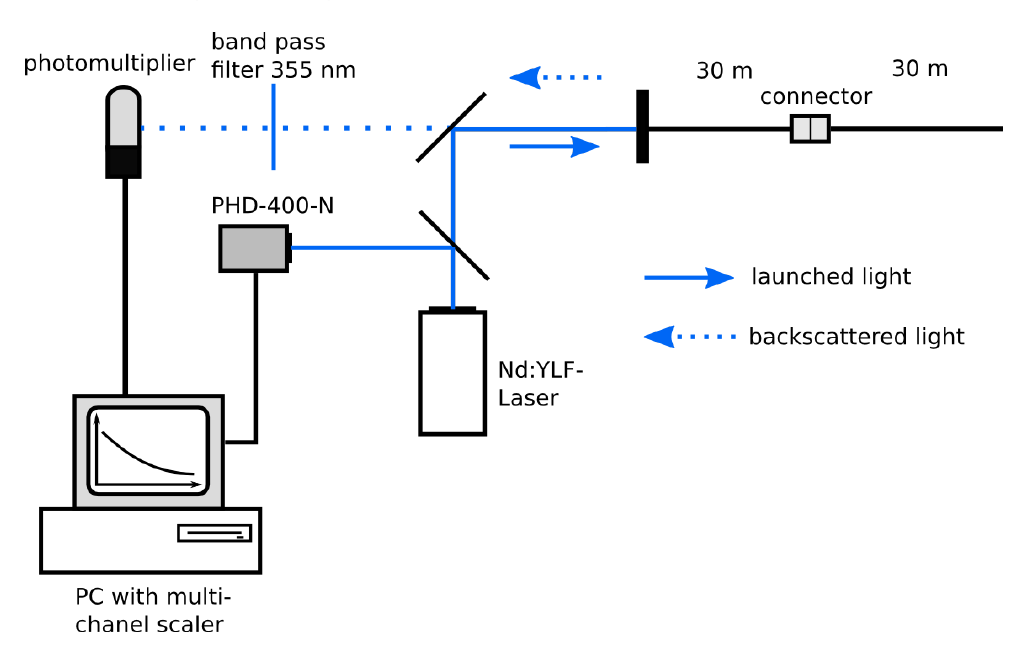
Figure 1. Optical setup of the reflectometer and fiber arrangement for the determination of parameters of the reflectometer; laser light passes a beam splitter for triggering the measurements and launches through a second beam splitter and collimator into two 30 m long connected fibers. Scattered light passes the second beam splitter, a band pass filter and is measured with a photomultiplier. Data are recorded with a multichannel scaler